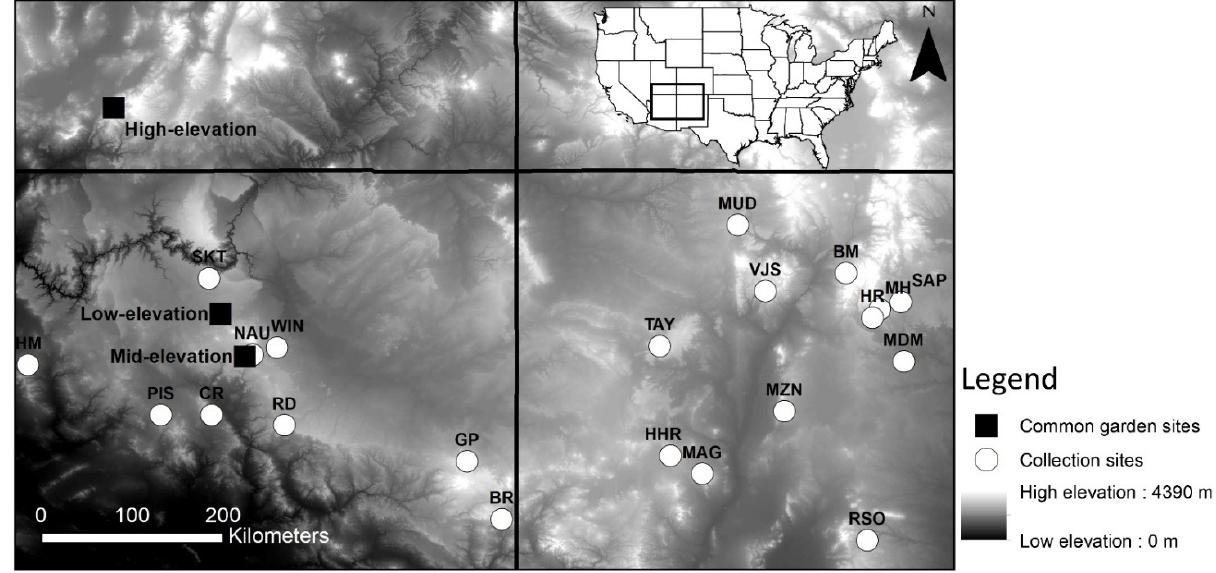
Figure 1. Location map of the 21 provenance collection sites and the location of the three field common gardens.